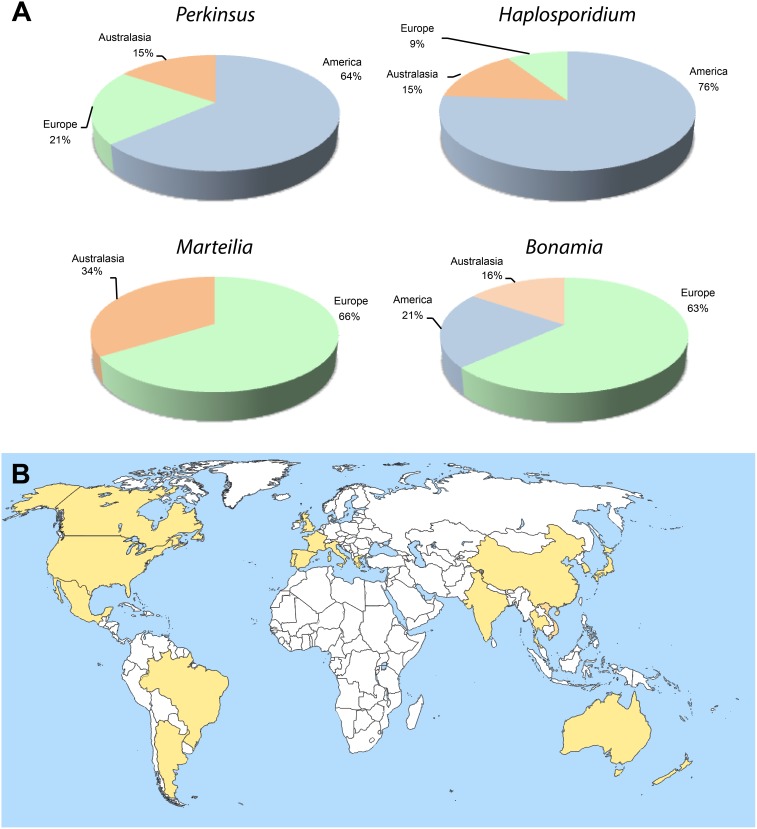
Distribution by continent of published papers in the literature reporting in the genera Perkinsus, Haplosporidium, Marteilia, and Bonamia (A). Countries where Perkinsus spp. have been reported by 2013 (B).